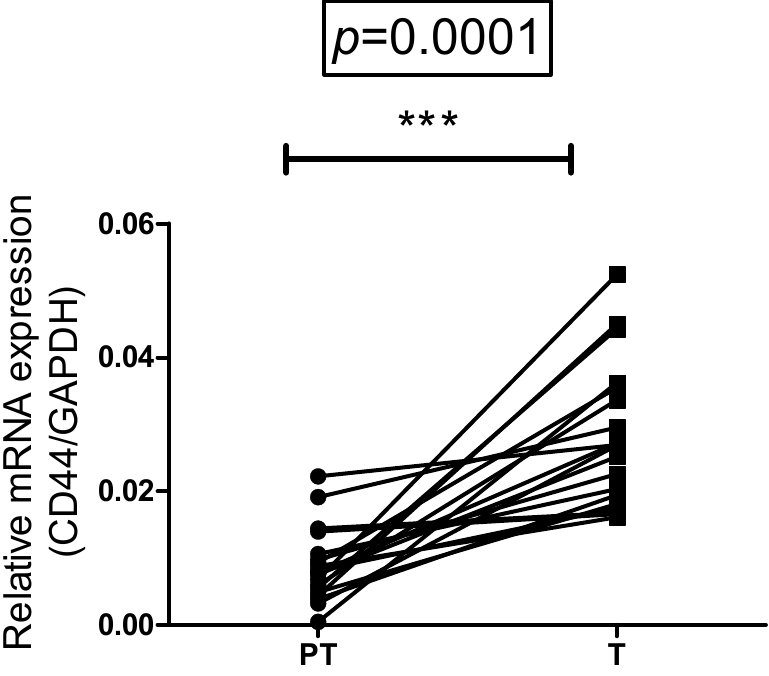
Figure 1. Comparative expression of CD44 mRNA in paired tumor and peritumor mucosa. Data are presented as relative mRNA expression of target gene to GAPDH. Wilcoxon matched pairs signed rank test, p < 0.0001. *** The difference between the matched pairs is statistical significant. The expression of total CD133 (PROM1) was assessed in paired samples of CRC tumors and adjacent tissue. Total CD133 expression was higher in tumor tissue, compared with paired non-invaded peritumor samples in 15.69%; in 47.06%, the expression was higher in non-malignant peritumor tissue, and in the remaining 37.25% the difference between paired samples was biologically insignificant (Figure